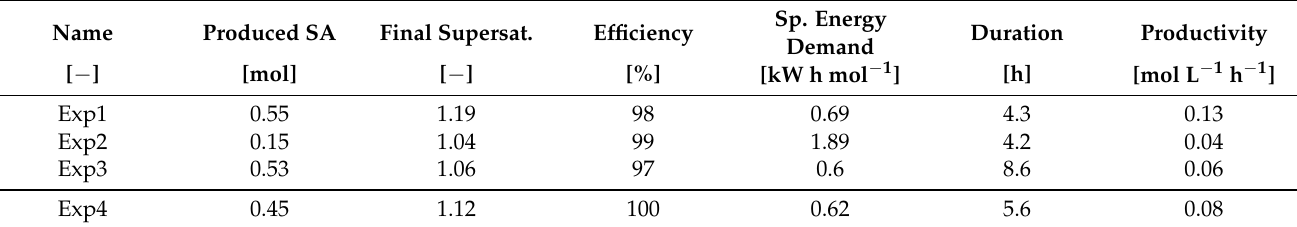
Figure 6. Electrochemical pH-shift crystallization in the prototype at 30°C, 0.1Acm − 2 and a volume flow rate ˙V of 0.52Lmin − 1 (Exp2). The black squares are the measured succinic acid concentration, the black cycles show the calculated supersaturation ratio S, and the two gray lines display the course of the pH value and voltage of Exp2. Table 5. Comparison of key performance parameters of the showcased